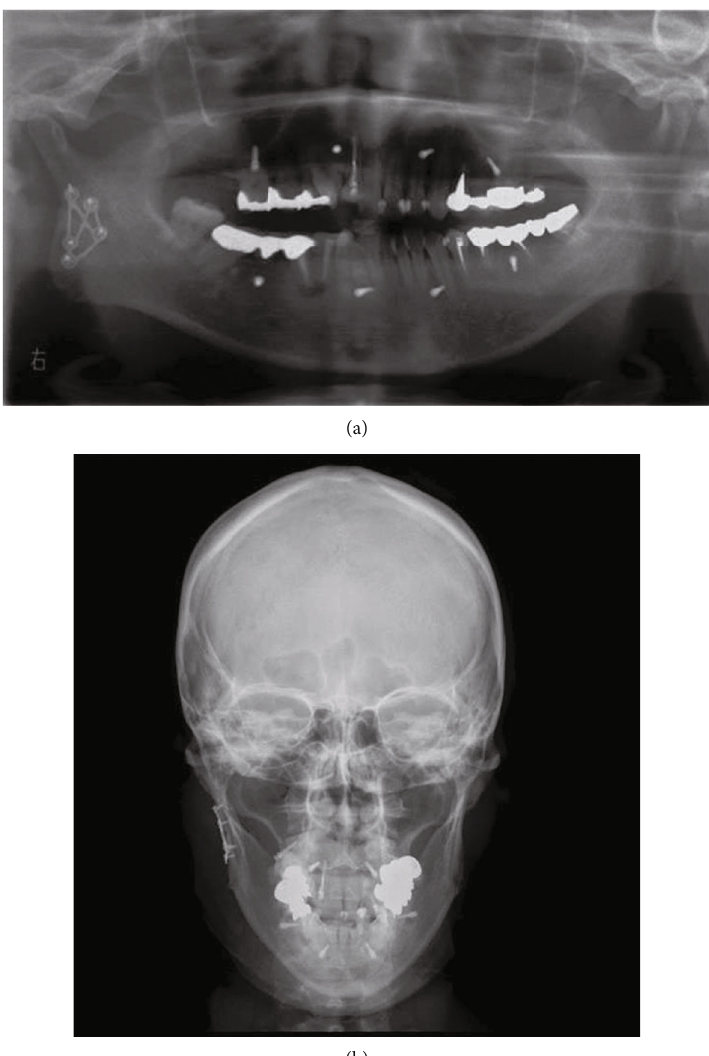
Figure 4: (a) Panoramic X-ray on the day after the surgery. The right mandibular condylar fracture is reduced and fi xed. (b) Head X-ray (PA) on the day after surgery. The bone fragment that was displaced externally is reduced and fi